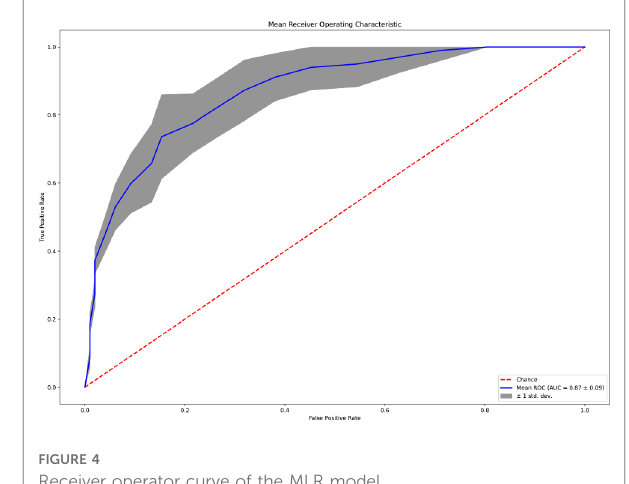
FIGURE 4 Receiver operator curve of the MLR